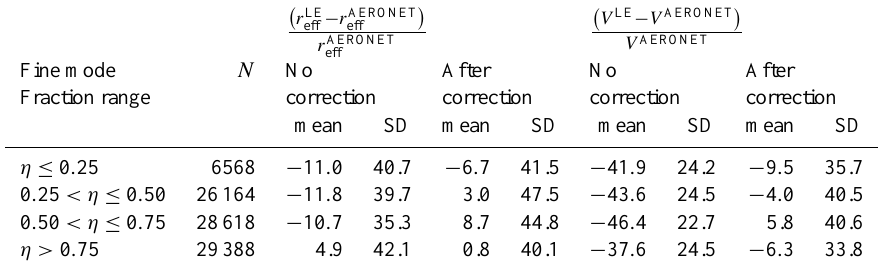
Table 3. Means and standard deviations of the relative differences between linear estimation (LE) and operational AERONET retrievals. For each interval of η is given values before and after applying corrections as well as the total number of